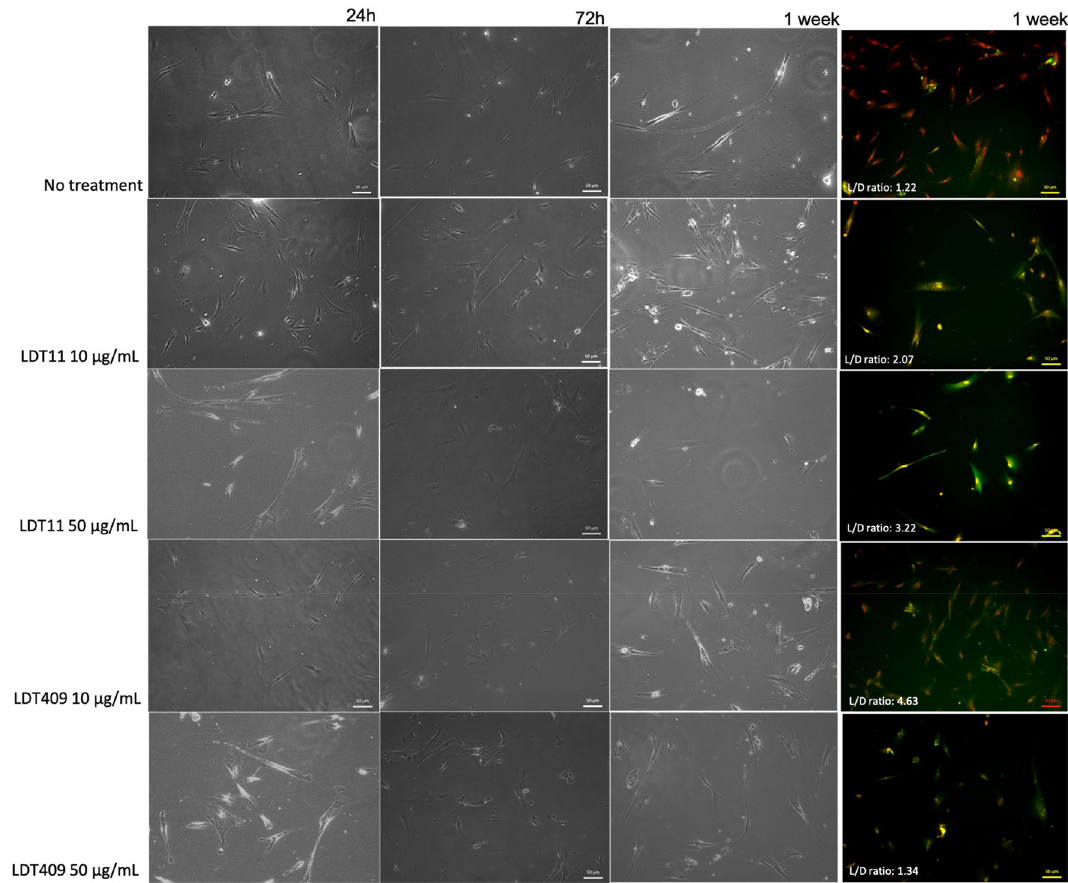
Figure 6. Impact of LDT11 and LDT409 on the morphology and viability of dental pulp stromal cells (HDPSc). Experiments were conducted over 24 h, 72 h, and 1-week using two concentrations of LDT11 and LDT409. HDPSCs were viewed using a light microscope and also stained with Live/Dead staining assay and imaged using fluorescent microscope with merged red and green filters (coloured images on the right side). Images were generated using ZEN 2012 v. 6.1.7601 (https:// www. zeiss. com/ micro scopy/ int/ produ cts/ micro scope- softw are/ zen.